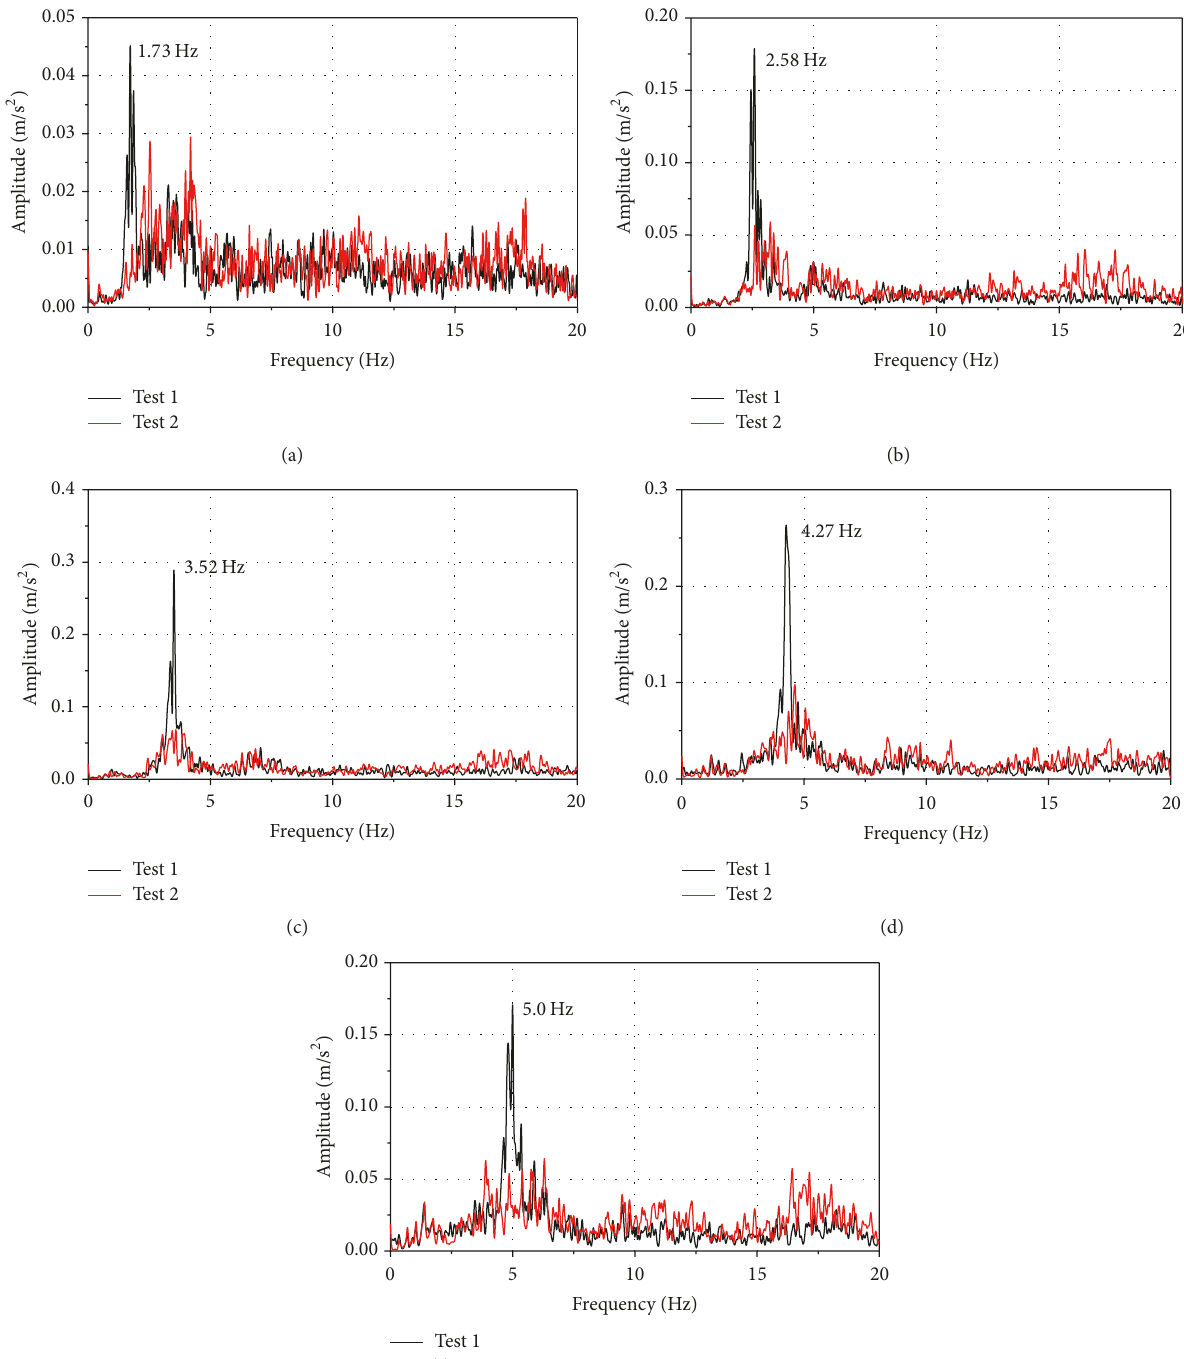
Figure 14: The comparison of frequency spectrum: (a) 10km/h, (b) 15 km/h, (c) 20 km/h, (d) 25 km/h, and (e) 30 km/h.